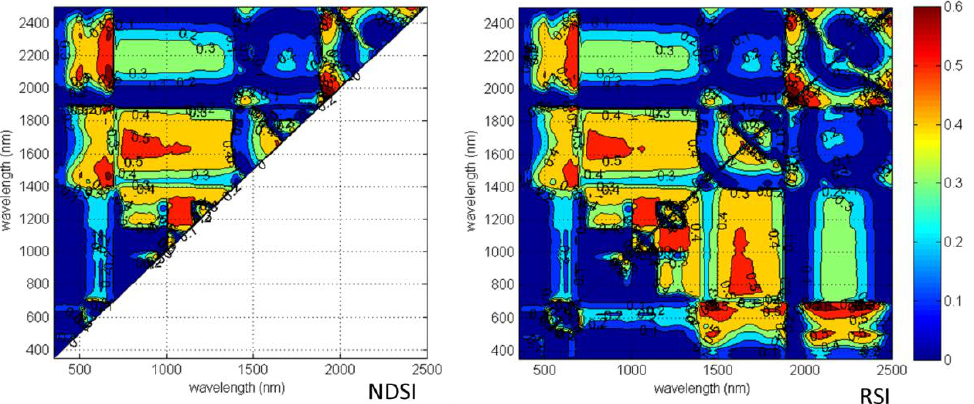
Figure 2. Contour maps of coefficients of determination (R 2 ) for linear relationship between NDSI,